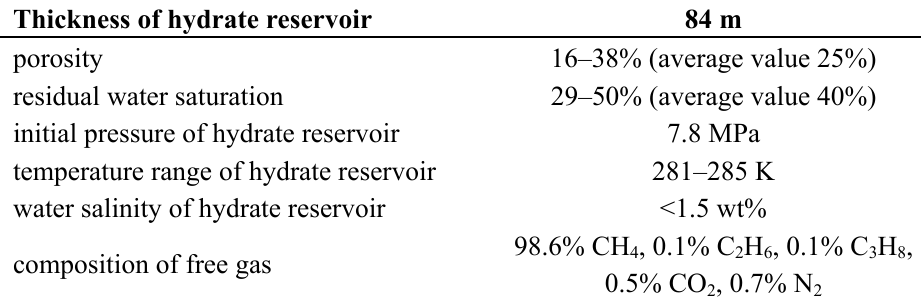
Table 3. Physical parameters of Messoyakha gas hydrate reservoir [115].